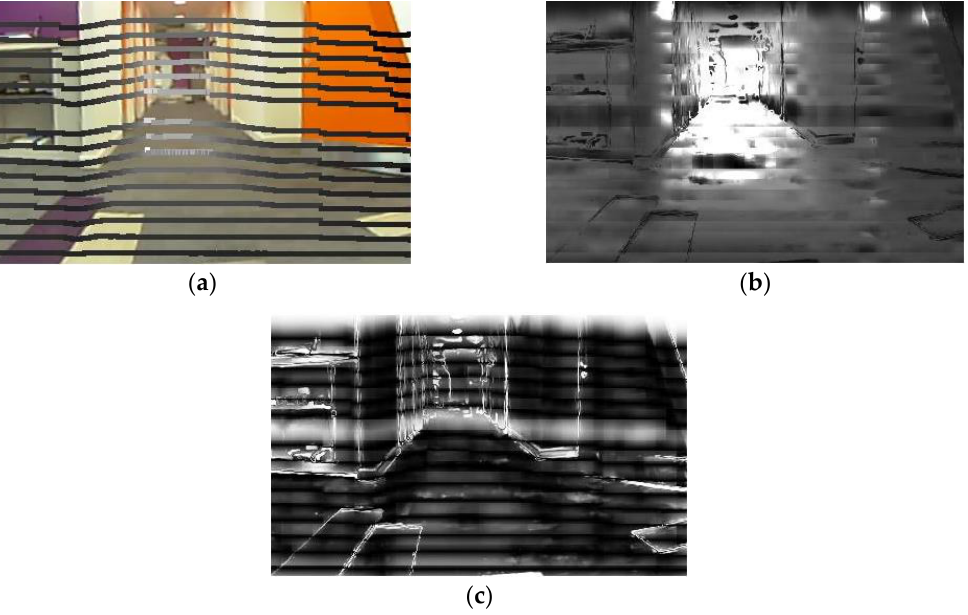
Figure 9. Visual illustration of the outputs of the Gaussian Process based resolution matching. ( a ) Aligned camera data and LiDAR points; ( b ) Output of Resolution matching step; ( c ) Uncertainty associated with depth estimation.